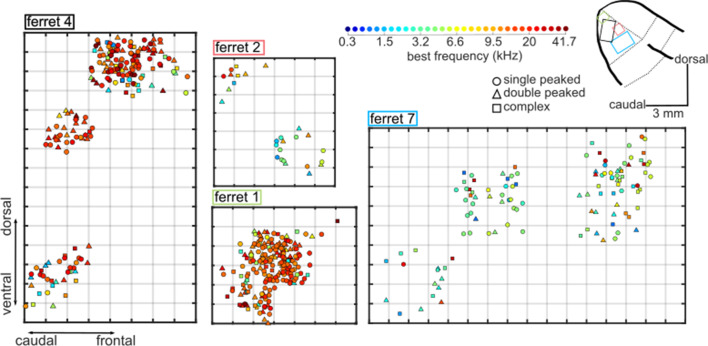
Spatial maps of best frequency in A1 of 4 ferrets.Each plot is a map of frequency-responsive neurons imaged in individual ferrets (ferrets 1, 2, 4 and 7). Neurons are plotted along the rostro-caudal and dorso-ventral axes. The color of each neuron indicates its BF, while the shape corresponds to the classification of its FRA (see legend, top center), as in Figure 2B. Each gray grid in the maps corresponds to a cortical area of 100 × 100 µm. The locations of the four maps within A1 are represented on a common map of ferret auditory cortex as colored rectangles (top right, color matches ferrets’ numbers).